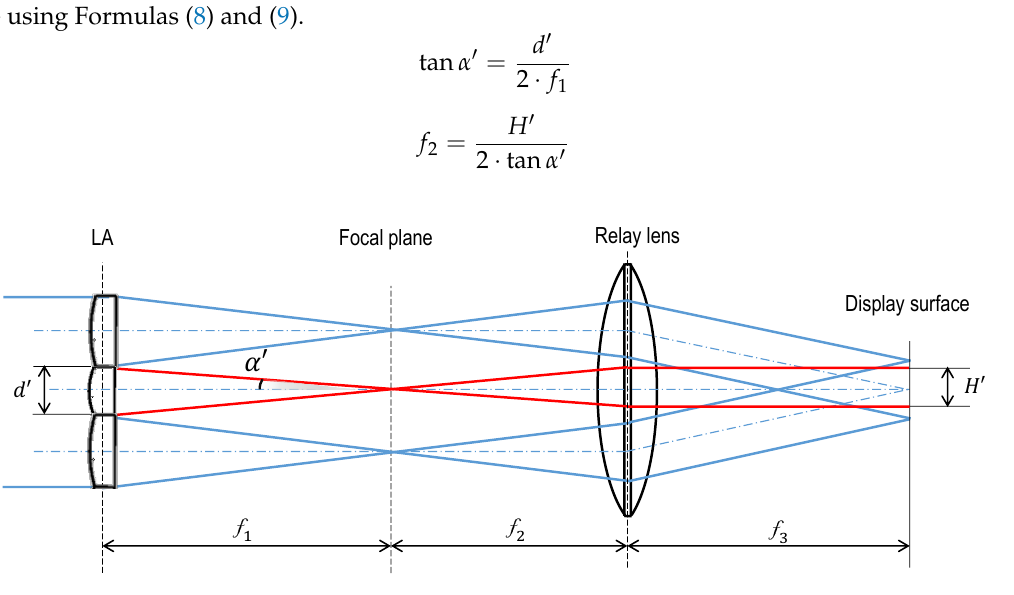
Figure 11. Principle of a aperture size changed LA inhomogenizer.